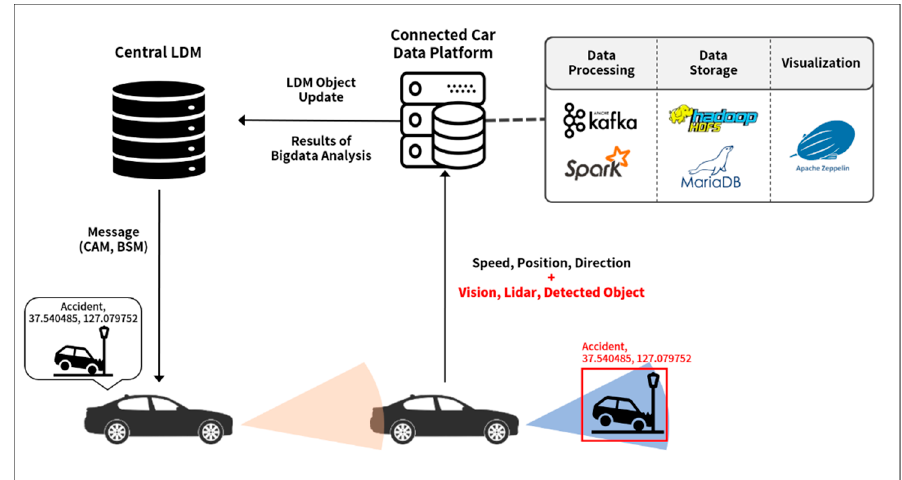
Figure 1. Sensor big data processing system for autonomous vehicles in the cooperative intelligent transport system environment.